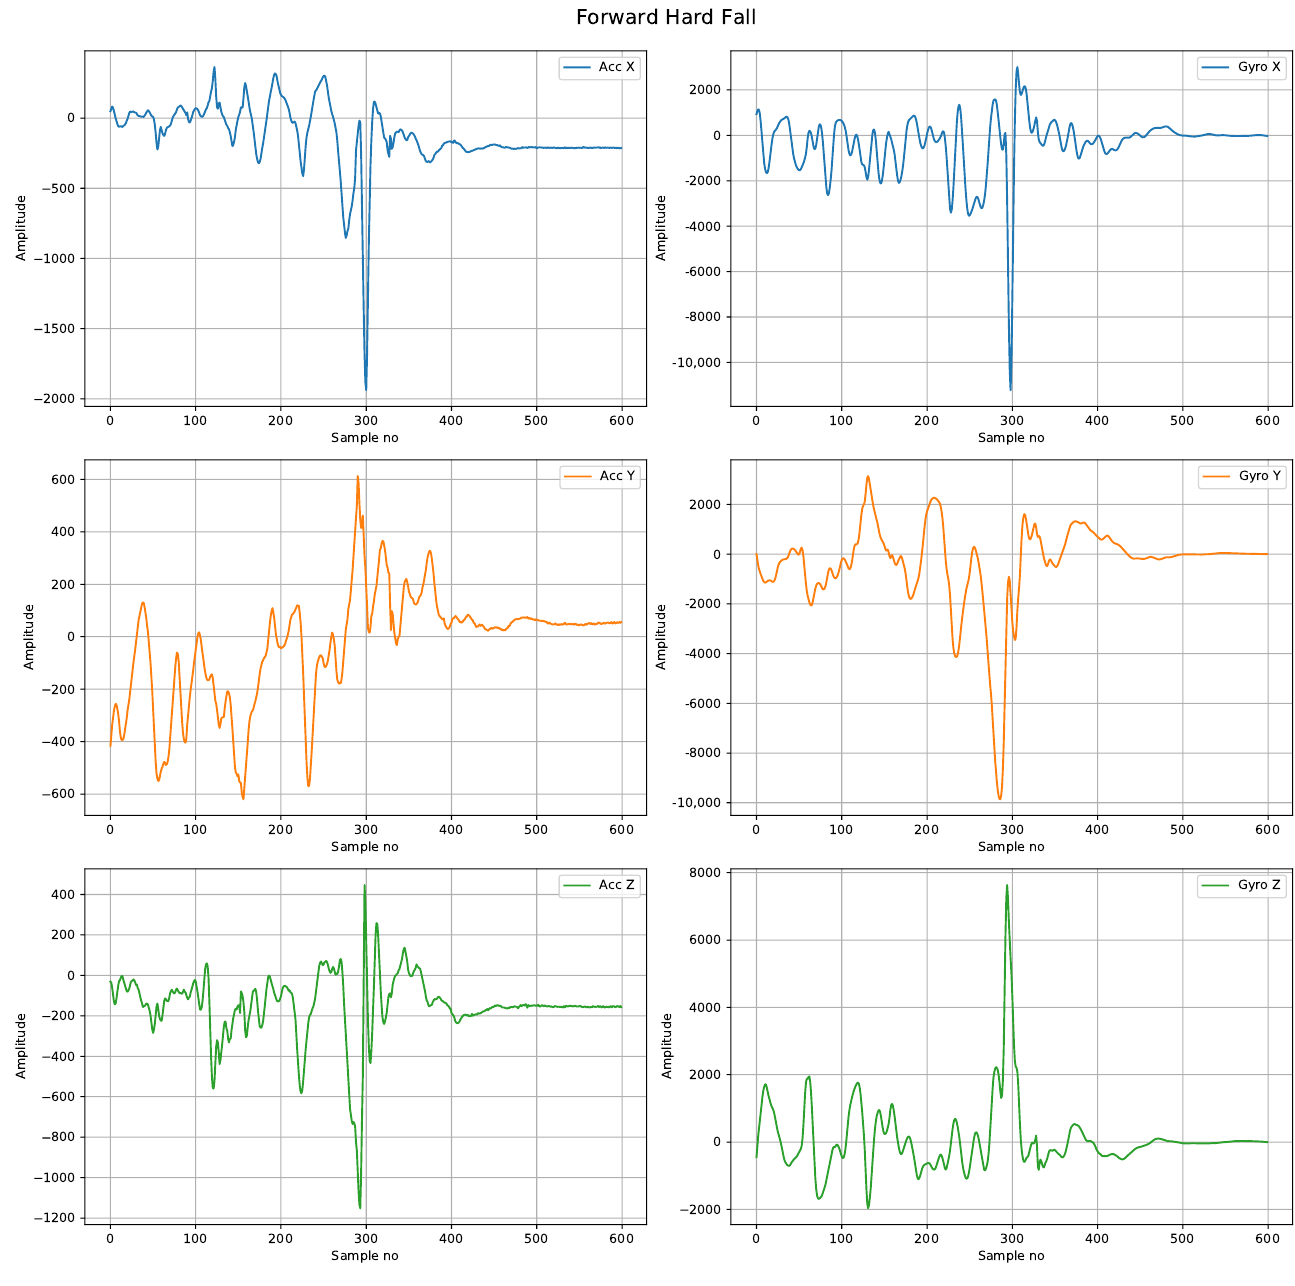
Figure A1. Accelerometer and gyroscope measurements: forward hard